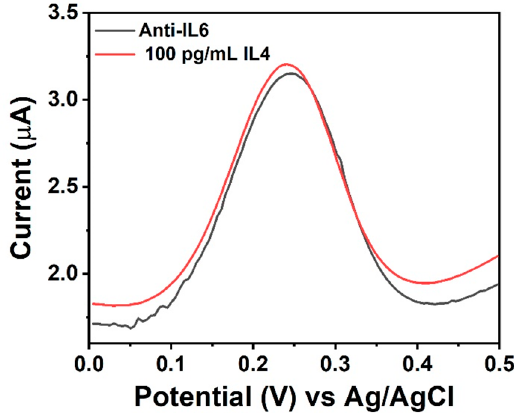
Figure 5. DPV curves of graphitic carbon biosensor (black curve) and biosensor exposed to 100 pg/mL of IL4 (red curve). DPV conducted in PBS at pH 7.4 containing 5 mM Fe(CN) 6 ] 3 − /4 −